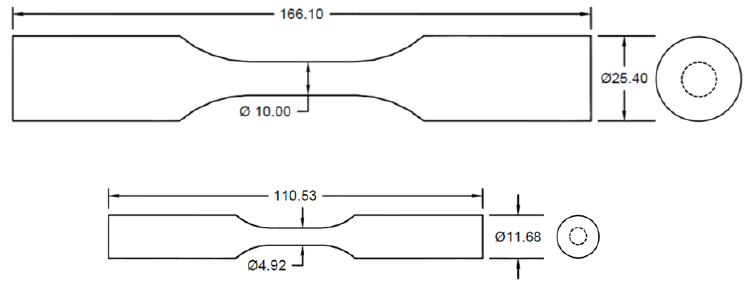
Figure 1. Illustration of the two specimen geometries used. Table 1. Classification of specimens based on the maximum defects detected in X-ray radiography as well as the volume fraction of the defects in small and large specimens measured from X-ray micro-computed tomography (µCT) scan results.